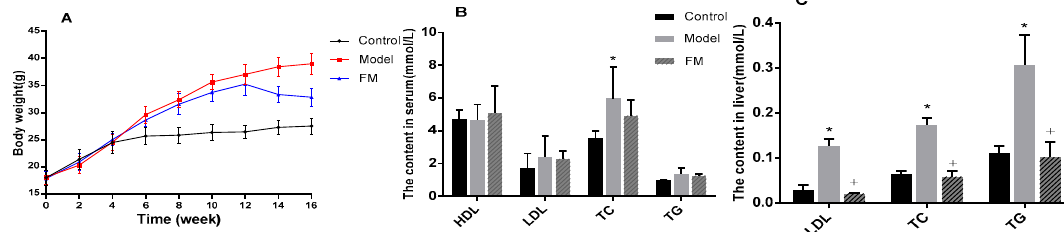
Figure 2. Effects of FM on body weight ( A ), TC, TG, LDL-C and HDL-C levels in serum ( B ) and TC, TG and LDL-C levels in liver ( C ). * p < 0.05 vs. control group. + p < 0.05 vs. model group.